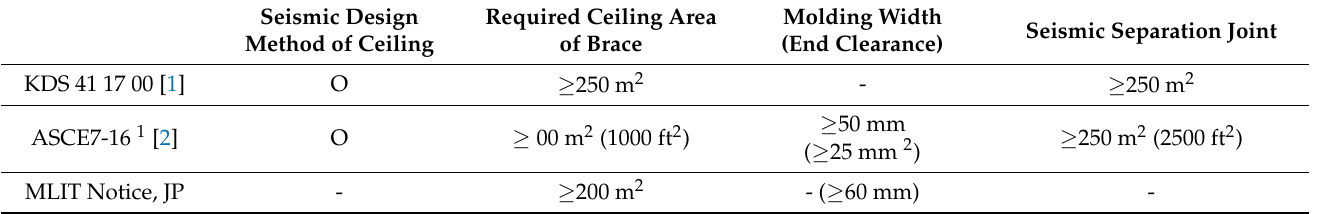
Table 1. Brief summary of the criteria on the brace installation of suspended ceilings.